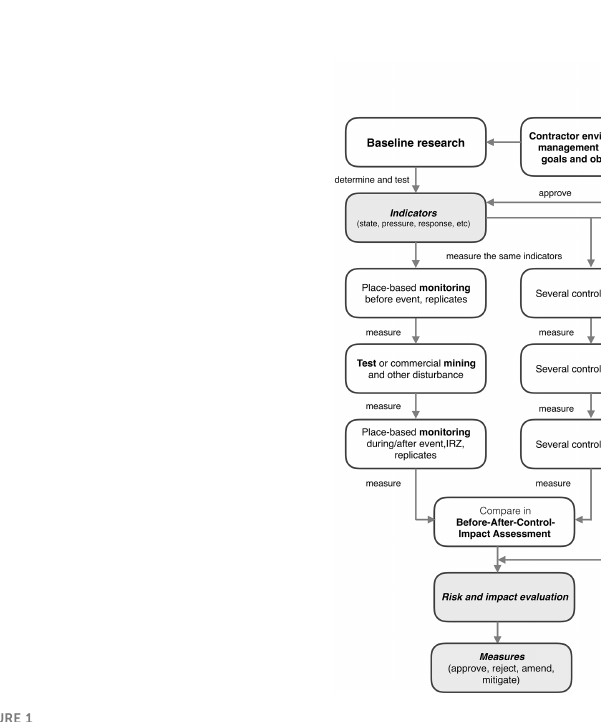
FIGURE 1 Timeline of key environmental management steps for seabed